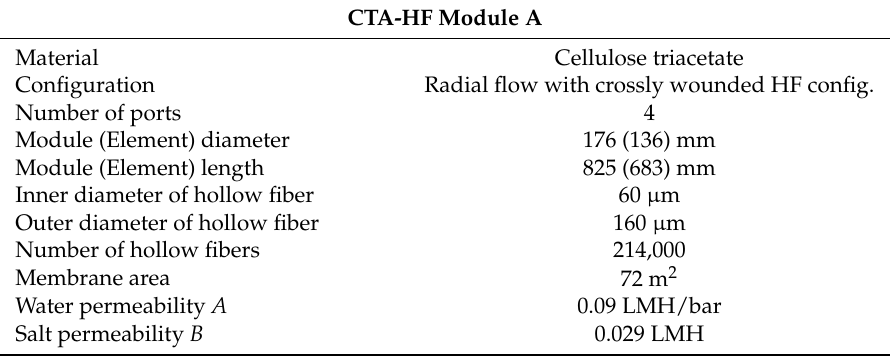
Table 1. Specifications and fundamental properties of the test module in the study